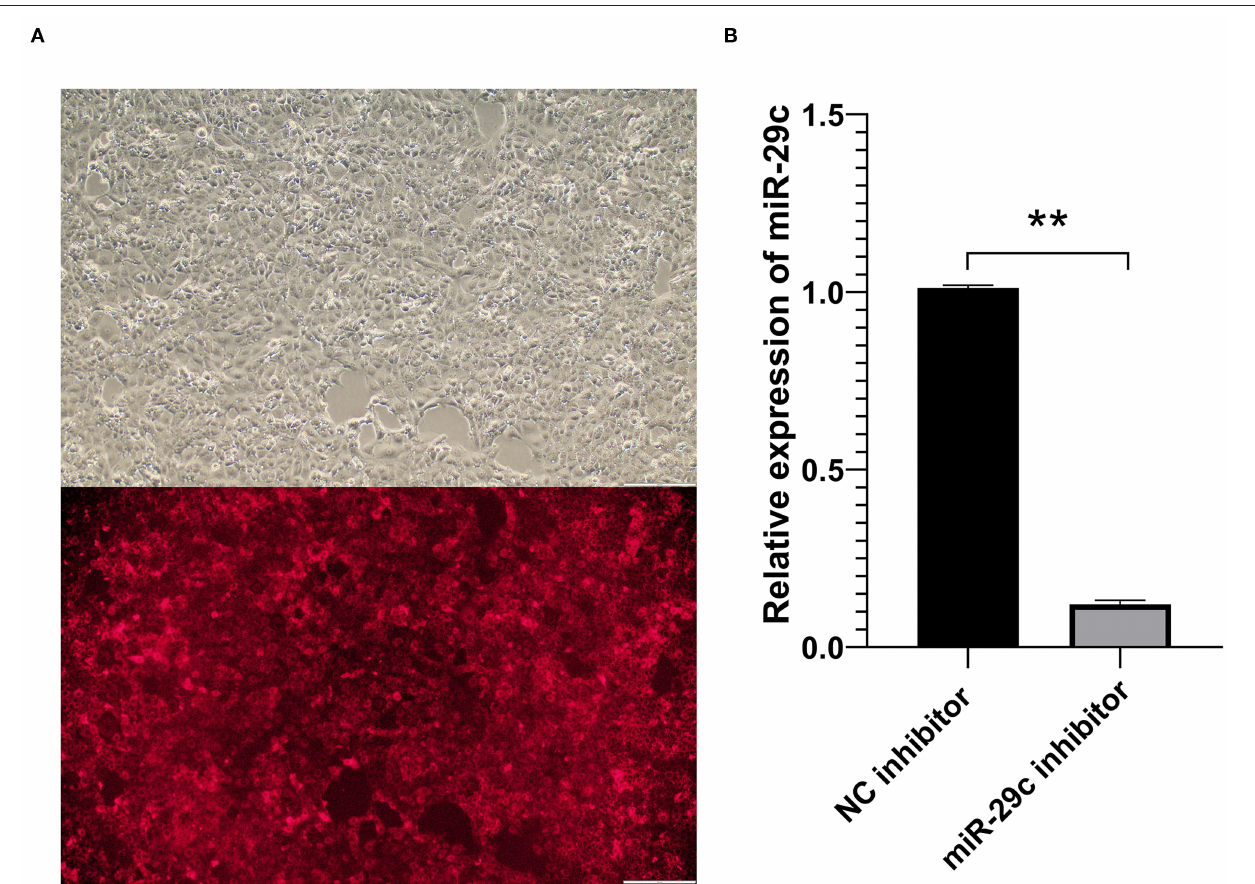
FIGURE 1 | Transfection efficiency detection of bovine miR-29c in MAC-T cells. (A) Transfection efficiency of NC inhibitor in MAC-T cells observed by fluorescence microscopy. (B) The transfection efficiency of bovine miR-29c inhibitor in MAC-T cells were measured by qRT-PCR. Data are presented as mean ± SEM. ** P < 0.01.